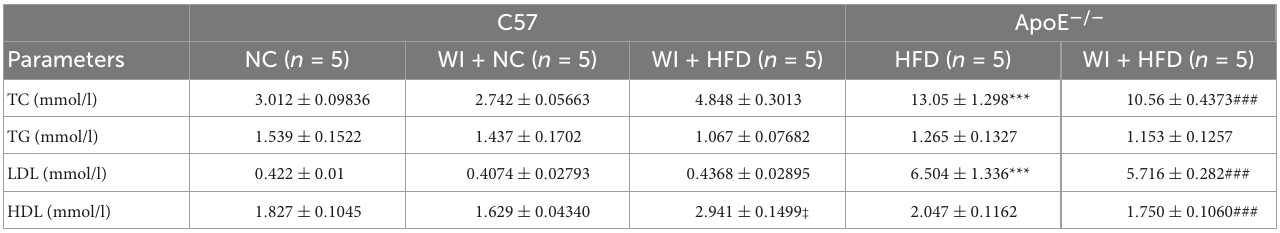
TABLE 2 Metabolic parameters in different groups of